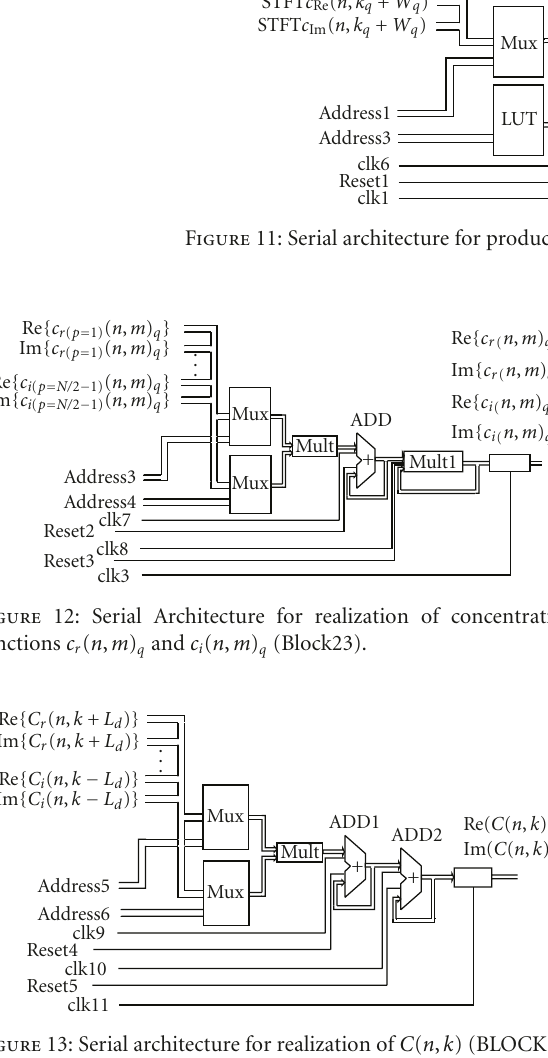
Figure 13: Serial architecture for realization of C ( n , k ) (BLOCK 4).